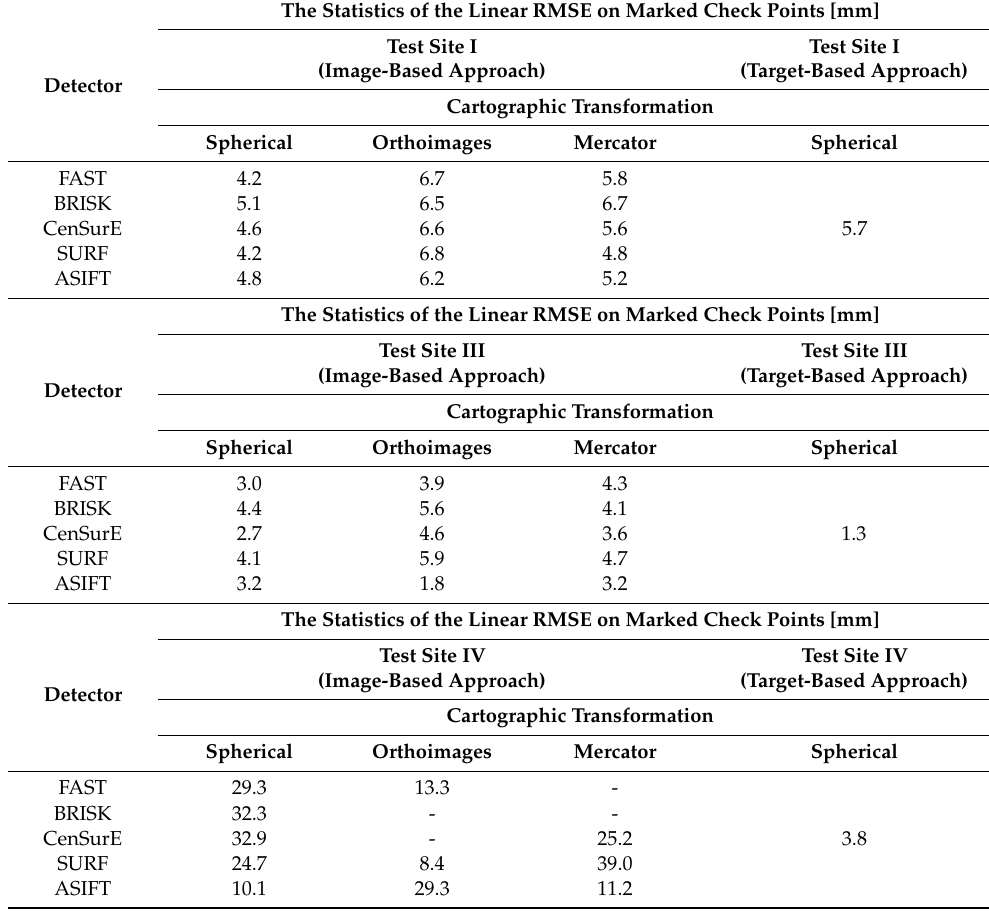
Table 6. Comparison of results of the TLS image-based method and the target-based registration